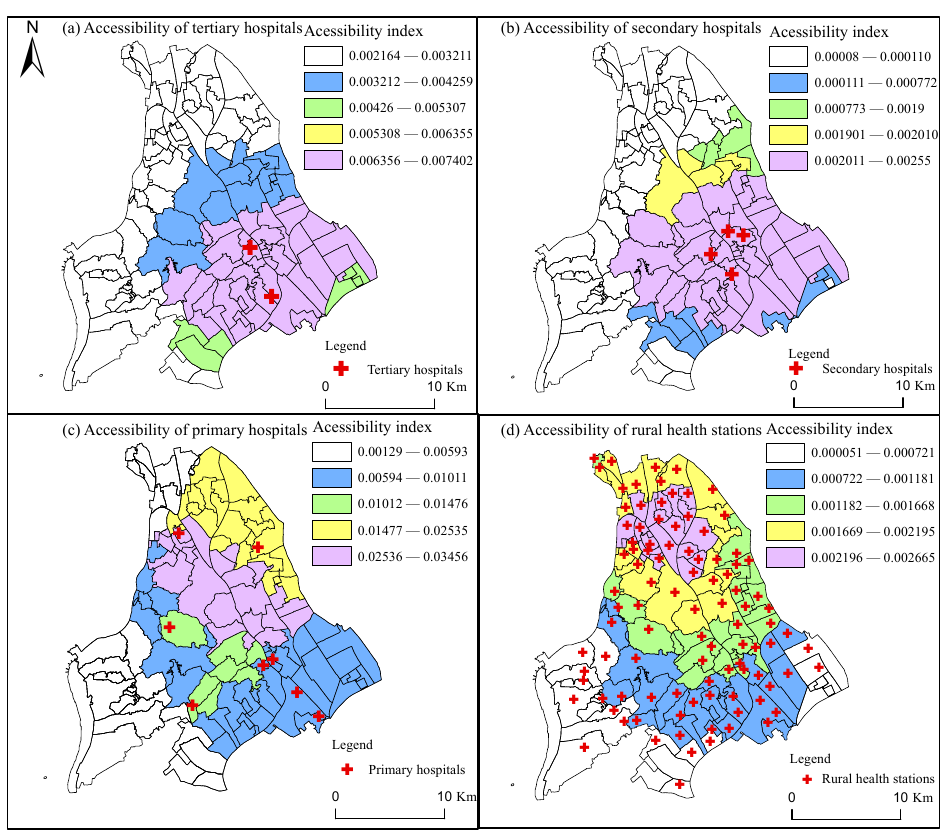
Figure 3. Spatial accessibility layout of public health facilities in the Doumen District of Zhuhai (Guangdong Province), China, 2020. ( a ) Accessibility of tertiary hospitals. ( b ) Accessibility of secondary hospitals. ( c ) Accessibility of primary hospitals. ( d ) Accessibility of rural health station. Table 2. Hospitals by service level. Doumen District of Zhuhai (Guangdong Province), China, 2020.